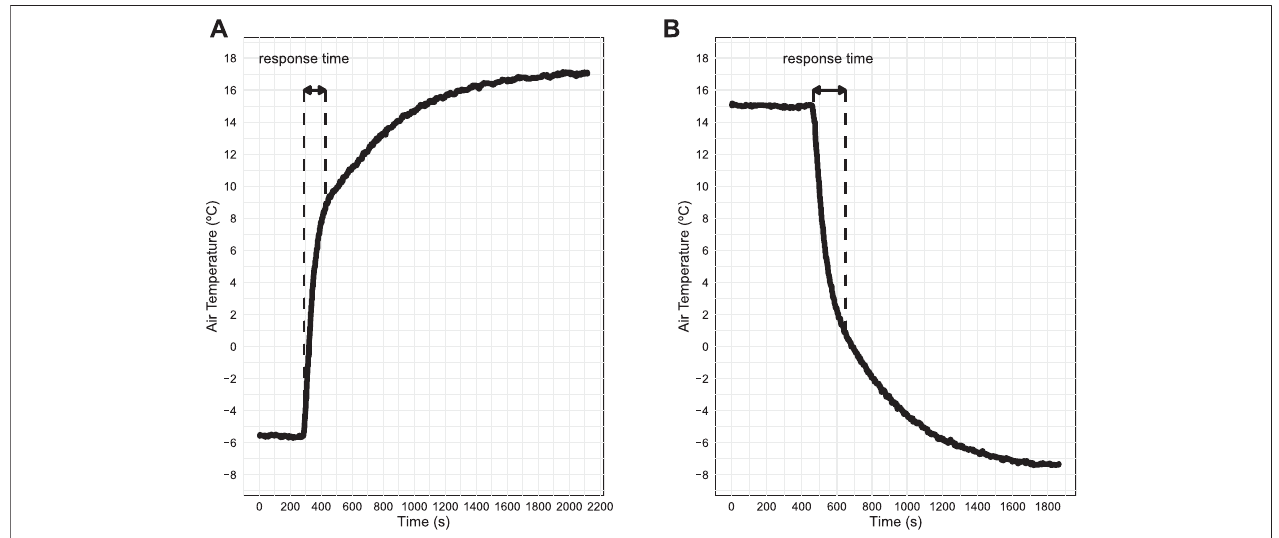
FIGURE2| Observedtemperature response forapositive (A) and negative (B) temperature exposureforoneofthe12experiments performed(seetext).Thetime axis represents time since start of the measurements (s). Dashed lines indicate the estimated response time ( τ